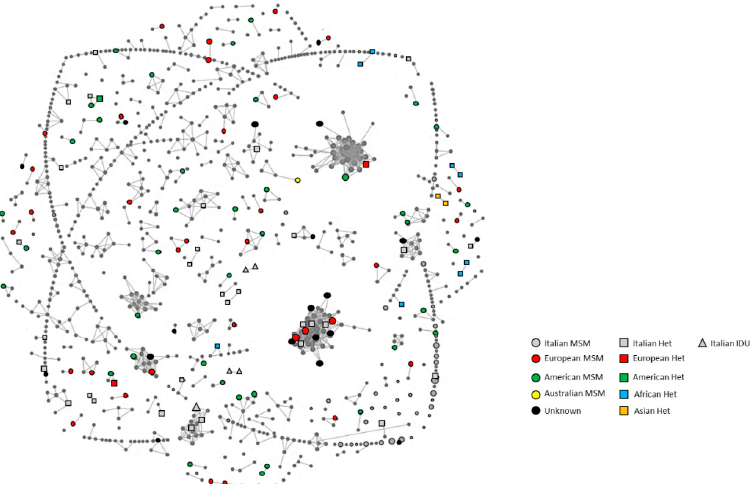
Figure 1. Clusters’ population by HIV-TRACE. The coloured geometric shapes identify the nationality and risk factors of the 3499 individuals involved in the study. Shapes without connections represent individuals not involved in molecular transmission clusters. Shapes connected with lines represent individuals involved in molecular transmission clusters.